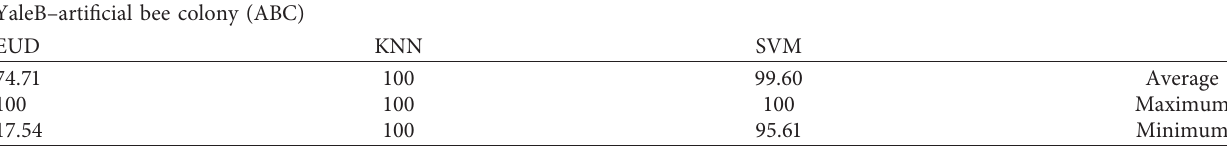
Table 4: Recognition accuracies for the YaleB database with the ABC algorithm.